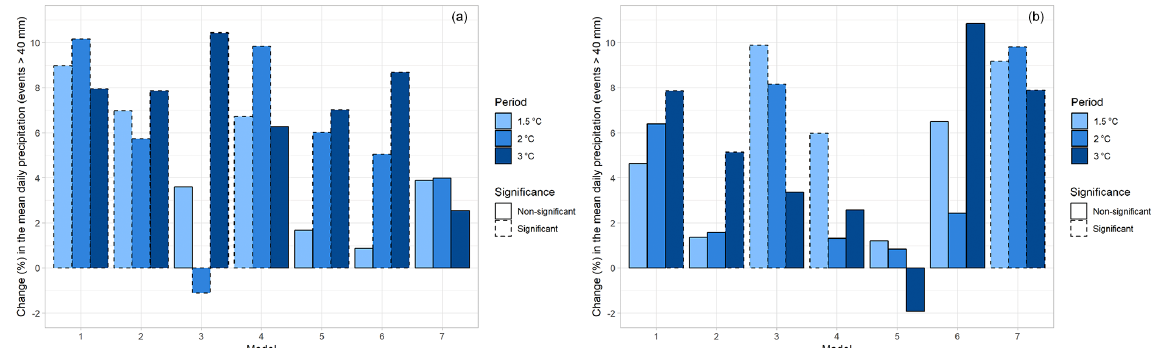
Figure 7. Change in the mean daily precipitation compared to the reference period (1976–2005) for cases exceeding the 40mmd − 1 threshold for the seven models and the three levels of warming in Catalonia (a) and the Valencian Community (b) . Dashed hatching around bars indicates significant changes ( p value < 0.05; Mann–Whitney test) with respect to the reference